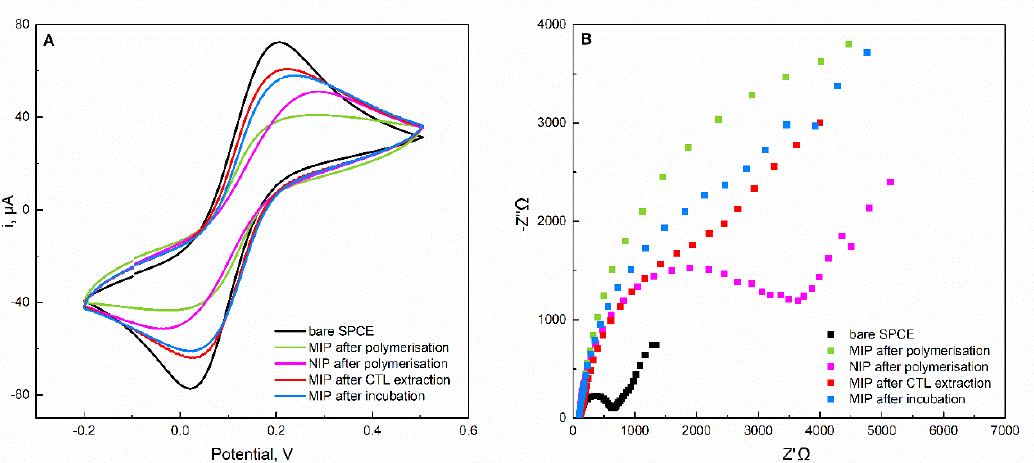
Figure 6. ( A ) Cyclic voltammograms and ( B ) impedance plots of a 2.5 mmol L − 1 [Fe(CN) 6 ] 3 − /4 − in 0.1 M KCl solution corresponding to the stepwise construction of the sensor. 0.1 M KCl solution corresponding to the stepwise construction of the